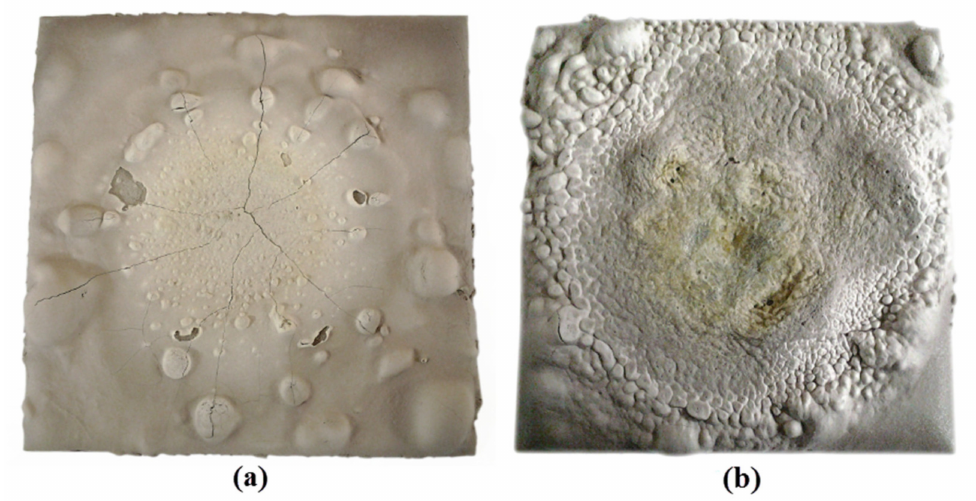
Figure 20. Mild steel plate coated with geopolymer binder for samples ( a ) S5 and ( b ) S7 after fire-retardant test.